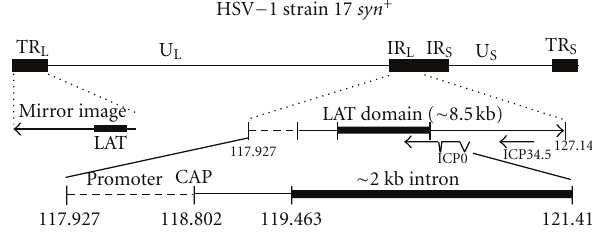
Figure 1: This figure depicts the linear HSV-1 strains 17 Syn+ noting specific regions of the genome. The abbreviations are as follows: TR L —terminal repeat long; TR S —terminal repeat short; U L —unique long; U S —unique short; IR L —internal repeat long; IR S —internal repeat short. Note that LAT is in two regions of the HSV-1 genome (TR L and IR L ). An 8.5 kb polyadenylated precursor is transcribed. Within the last domain are two very important immediate-early genes, ICP0 and ICP34.5. Also note the promoter, the CAP site, and a 2.0kb intron. Further modification results in a 1.5kb smaller